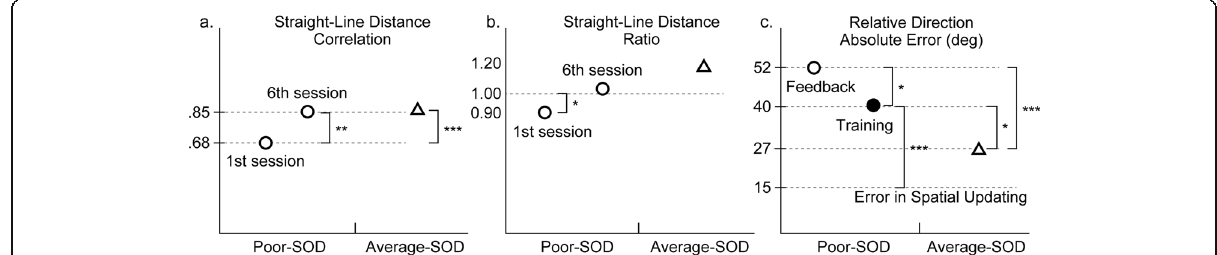
Fig. 6 Schematic illustrations of the effects of feedback and training on straight-line distance estimates (distance correlations ( a ) and ratios ( b )) and relative direction estimates ( c ). SOD, sense of direction. The accuracy of straight-line distance estimates was improved to the level equivalent to the average-SOD group over the course of repeated trials with feedback. Training improved the performance on relative direction judgments to a certain degree, but did not negate the difference between the poor- and average-SOD groups. * p < .05; ** p < .01; *** p <